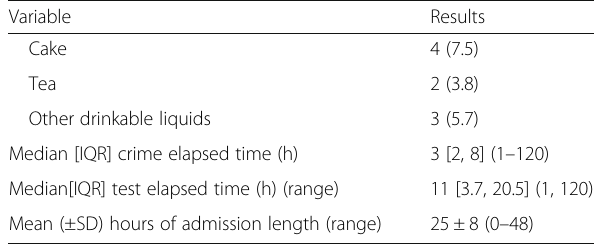
Table 1 Demographic and basic characteristics of the drug- facilitated crime victims